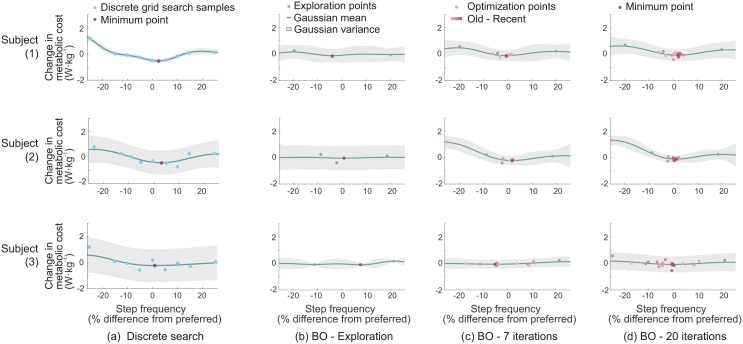
Gaussian process fits to discrete grid search results (a) and Bayesian optimization (BO) results at three time points in our study (b, c, d) for three subjects (subjects 1, 2, 3).The y axis shows normalized metabolic cost calculated by subtracting normalized mean metabolic cost. Subfigure (b, c, d) show posterior distributions after three initial exploration step frequencies (a), after seven iterations before the experimental break, and the final posterior distribution after 20 iterations (d). In each case, Bayesian optimization quickly identified a low-cost step frequency within 10 iterations despite qualitative differences in the cost landscape.